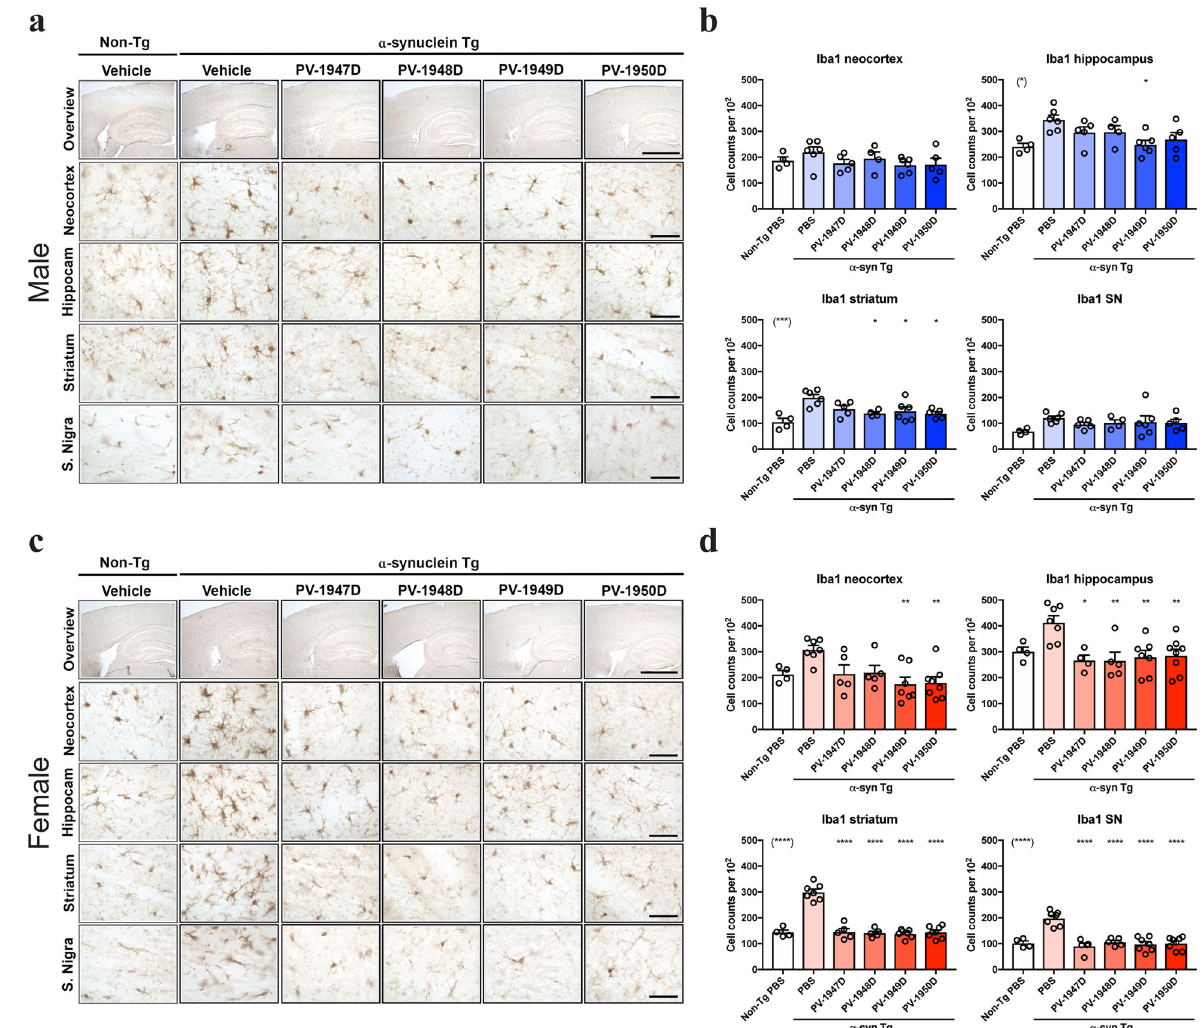
Fig. 8 Vaccination with MultiTEP-based DNA vaccines signi fi cantly reduced microgliosis in α -synuclein transgenic mice. a Representative images of the brain sections from male mice immunostained with an antibody against the microglial cell marker -Iba1. Each panel from top to bottom represents an overview of the brain, neocortex, hippocampus, striatum, and substantia nigra regions in non-Tg, and α Syn Tg mice with a vehicle, PV-1947D, PV-1948D, PV-1949D, and PV-1950D vaccination. b Image analysis of Iba1 positive cell count per 10 2 in the neocortex, hippocampus, striatum, and substantia nigra of male mice. c Representative images of the brain sections of female mice immunostained with an antibody against the microglial cell marker Iba1. Each panel illustrates from top to bottom an overview of the brain, neocortex, hippocampus, striatum, and substantia nigra regions in non-Tg, and α Syn Tg mice with a vehicle, PV-1947D, PV-1948D, PV-1949D, and PV-1950D vaccination. d Image analysis of Iba1 positive cell counts in the neocortex, hippocampus, striatum, and substantia nigra of female mice. The scale bar in the overview is 250 µm, the others are 25 µm. * p < 0.05, ** p < 0.01, *** p < 0.001, **** p <